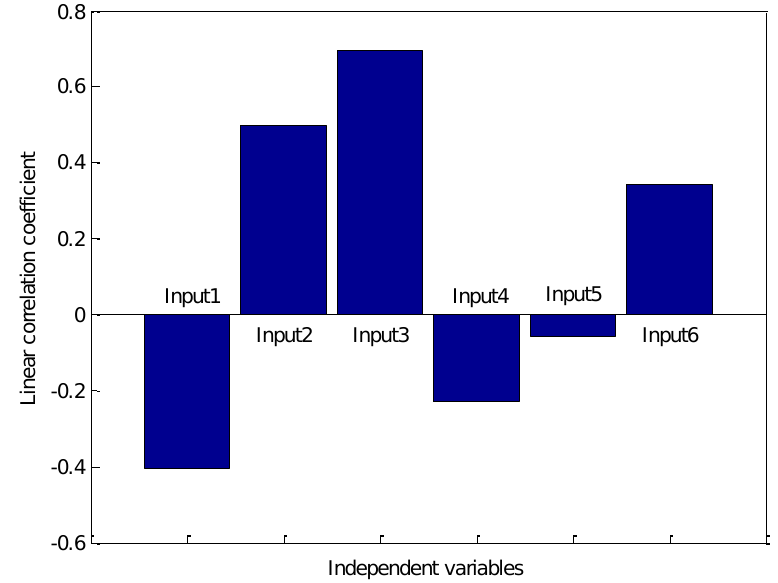
Figure 3. Pearson correlation coefficients between each pair of independent variables.